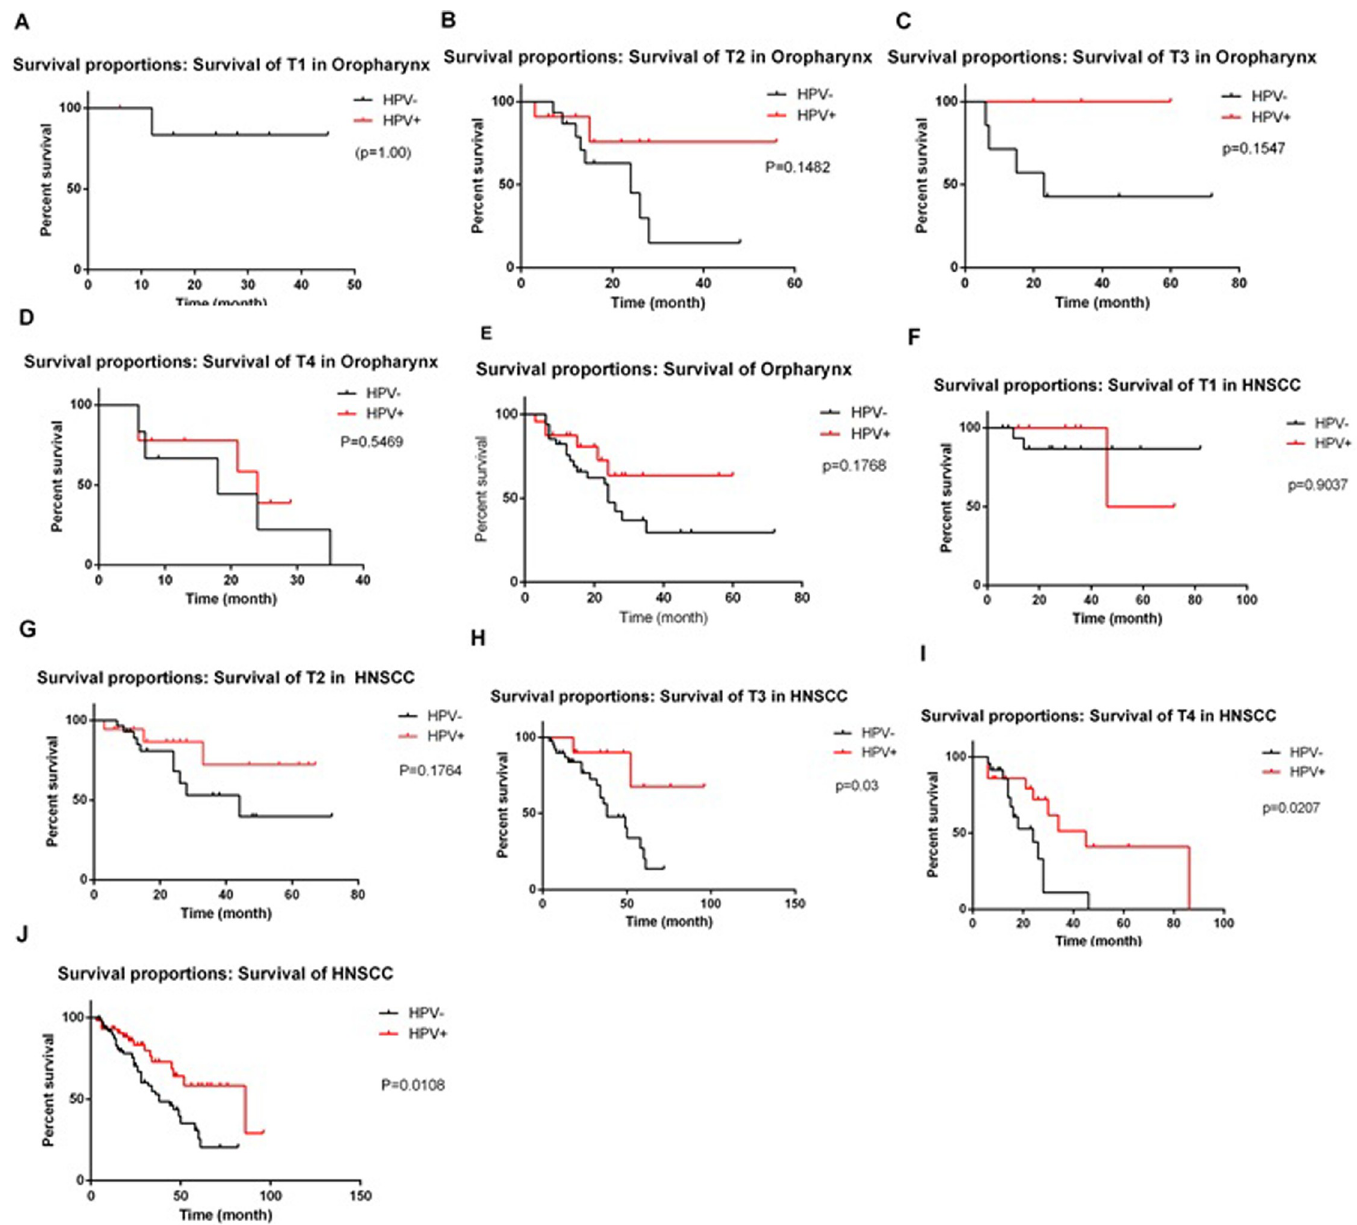
Fig 3. HPV status as a predictor of survival following treatment. Oropharyngeal cancer survival is shown by tumour stage at treatment (a) T1 (b) T2 (c) T3 (d) T4 (e) all tumours. HNSCC survival is shown by tumour stage at treatment (f) T1 (g) T2 (h) T3 (i) T4 (j) all tumours. The significances of the survival differences by log-rank analysis are